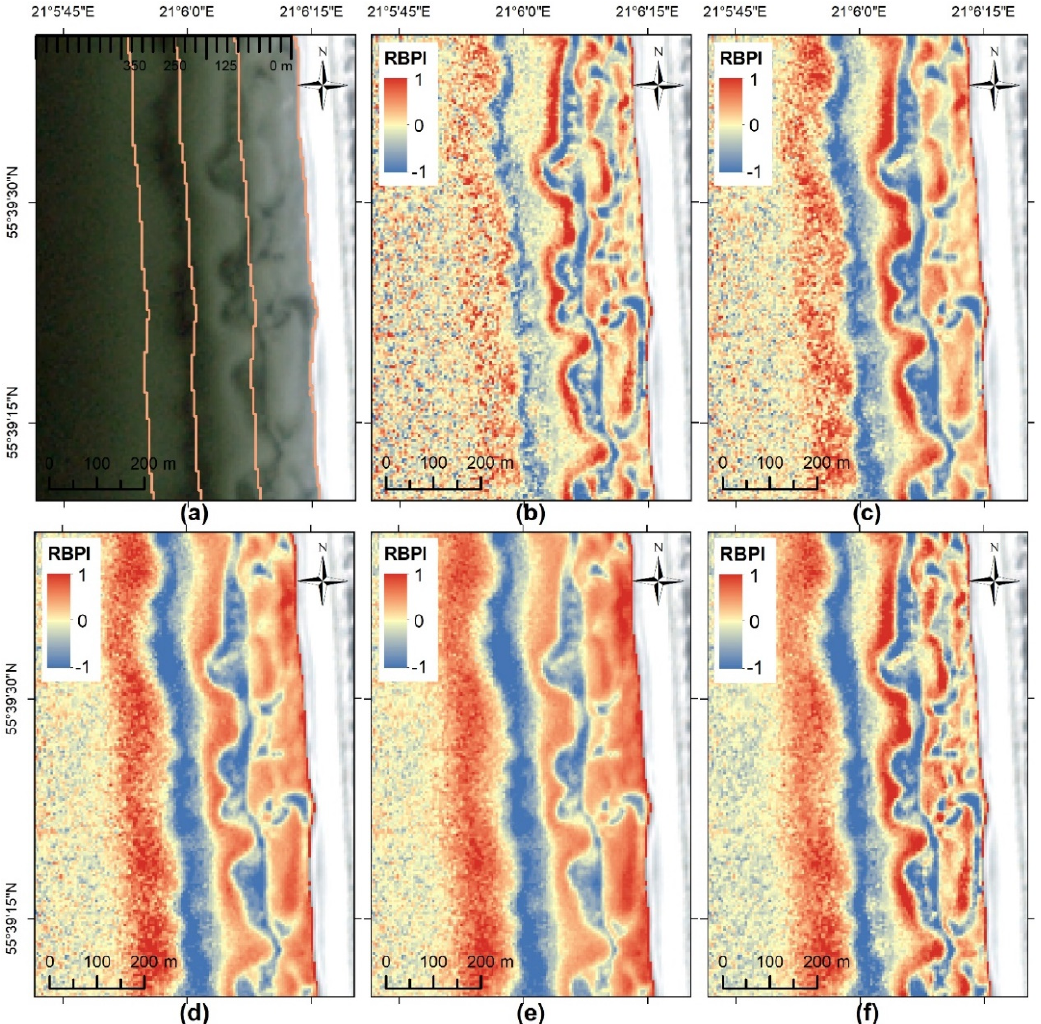
Figure 4. The Relative Bathymetric Position Index (RBPI) dependence on local neighbourhood size and multiscale approach solution: ( a ) nearshore cross-shore-distance-based sectors used in this study; ( b – e ) the mean RBPI in different size local neighbourhoods (( b ) circle 3, 5, 7, 9; ( c ) circle 9, 11, 15; ( d ) circle 15, 19, 23, 31; ( e ) circle 23, 31, 39; ( f ) multiscale RBPI with the combination of ( b – e ) neighbourhoods in nearshore cross-shore-distance-based sectors.